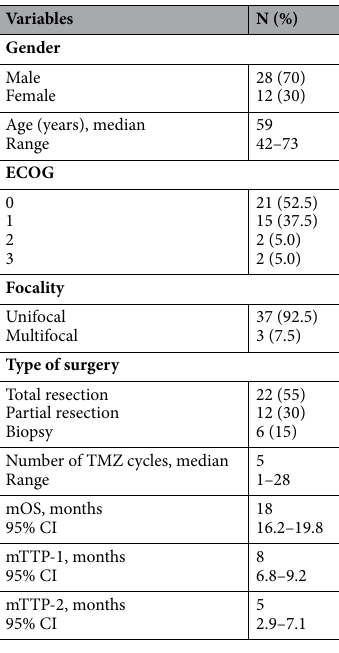
Table 1. Clinical and demographic characteristics of GBM patients. ECOG Eastern Cooperative Oncology Group performance status, TMZ temozolomide, mOS median overall survival, mTTP-1 median time to progression after temozolomide, mTTP-2 median time to progression after bevacizumab, 95% CI 95% confidence